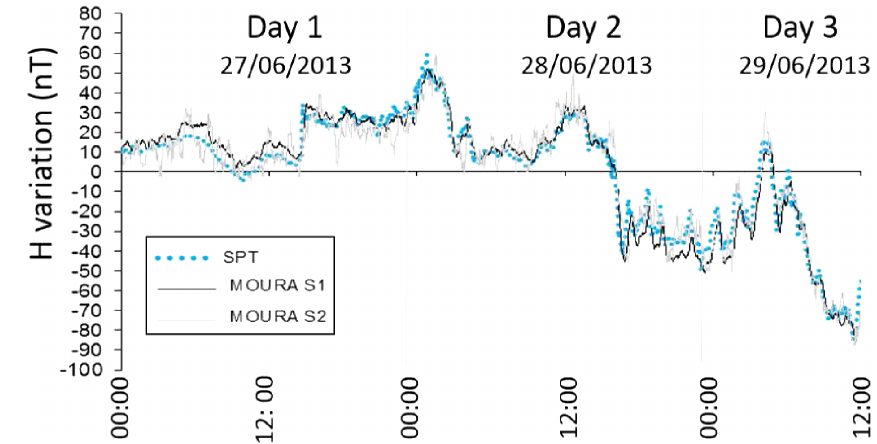
Figure 15. Horizontal component of the geomagnetic field measured with MOURA magnetometer and SPT reference magnetometers on 28–29 June